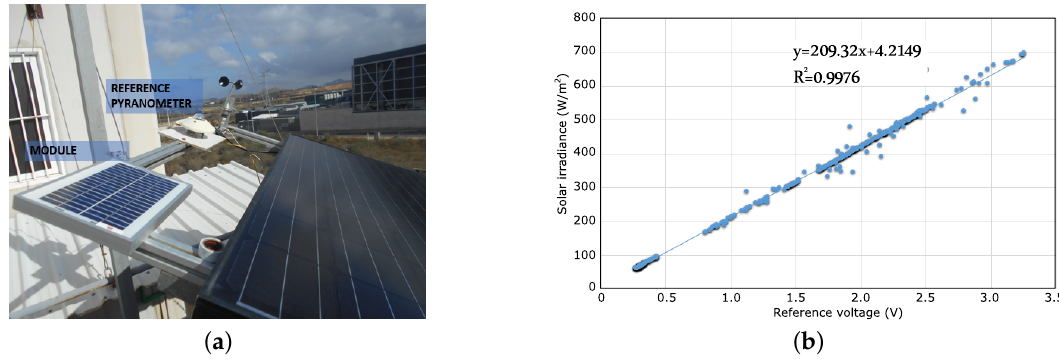
Figure 3. Pyranometer module calibration: ( a ) real PV installation; and ( b ) pyranometer